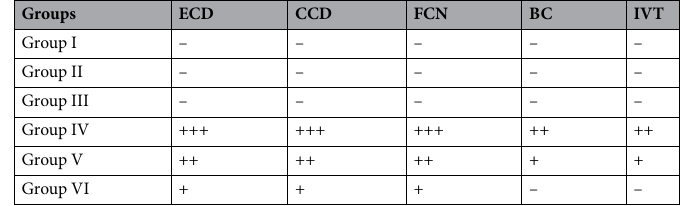
Table 3. Protective role of Bmex against glyphosate-induced meristematic cell damage. Group I: Control, Group II: 350 mg/L Bmex, Group III: 700 mg/L Bmex, Group IV: 500 mg/L glyphosate, Group V: 500 mg/L damage, (+): little damage, (++): moderate damage (+++): severe